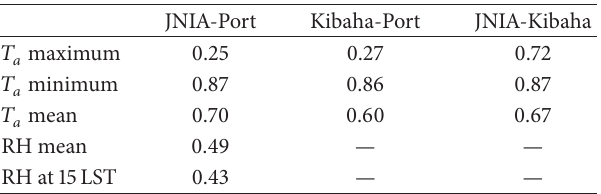
Table 2: Kendall’s tau correlation coefficients at a significant level of 0.05 for intra-urban temperature and relative humidity differences between the three stations.